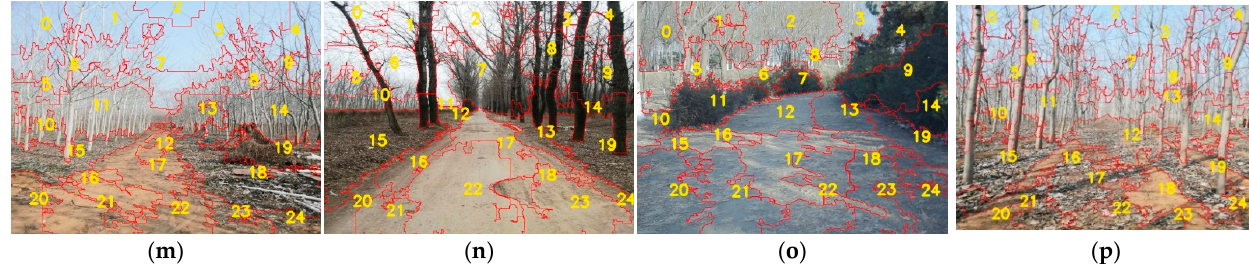
Figure 6. Superpixels segmentation and calibration results of unstructured roads based on improved SEEDS algorithm in forest areas. ( a – f ) are from RUGD; ( g – k ) are from Jiufeng Forest Farm; ( l – p ) are from Liaocheng Forest Farm.